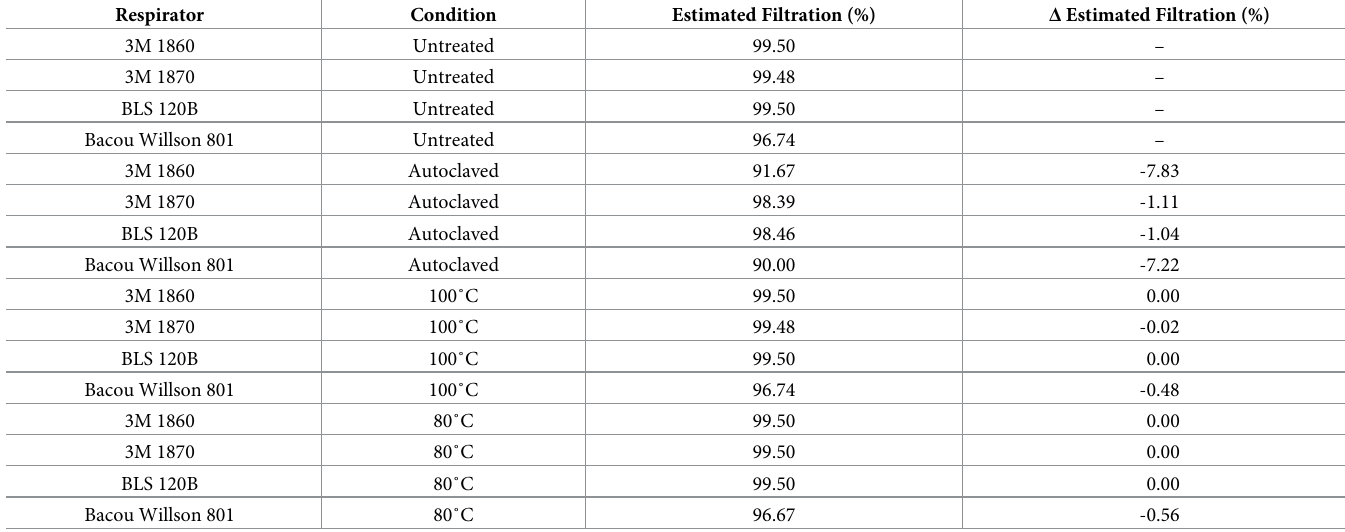
Table 2. Estimated filter efficiency derived from fit factors obtained from the PortaCount Pro